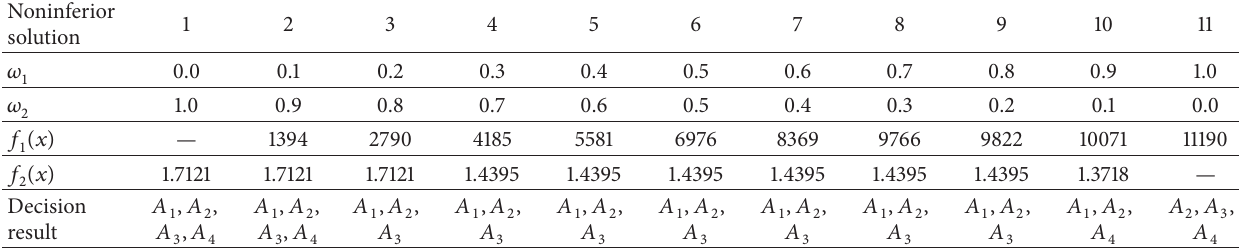
Table 8: The noninferior solutions in different combinations of